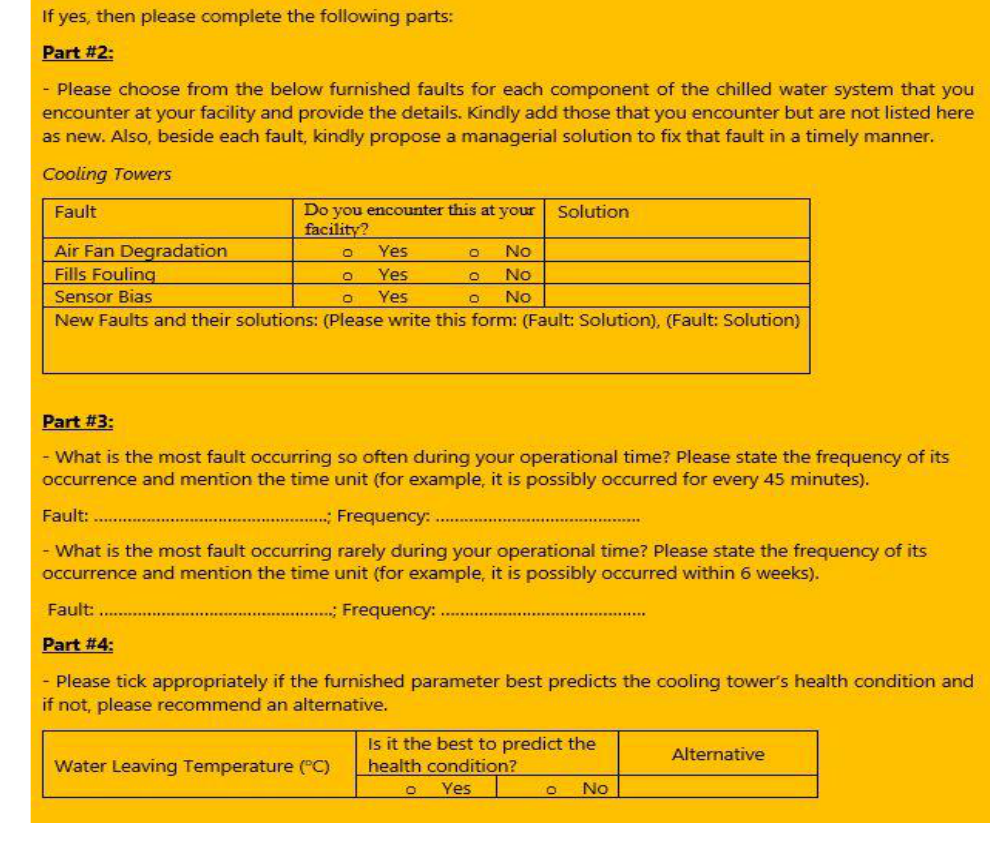
Figure 3. Excerpt of cooling tower’s survey .